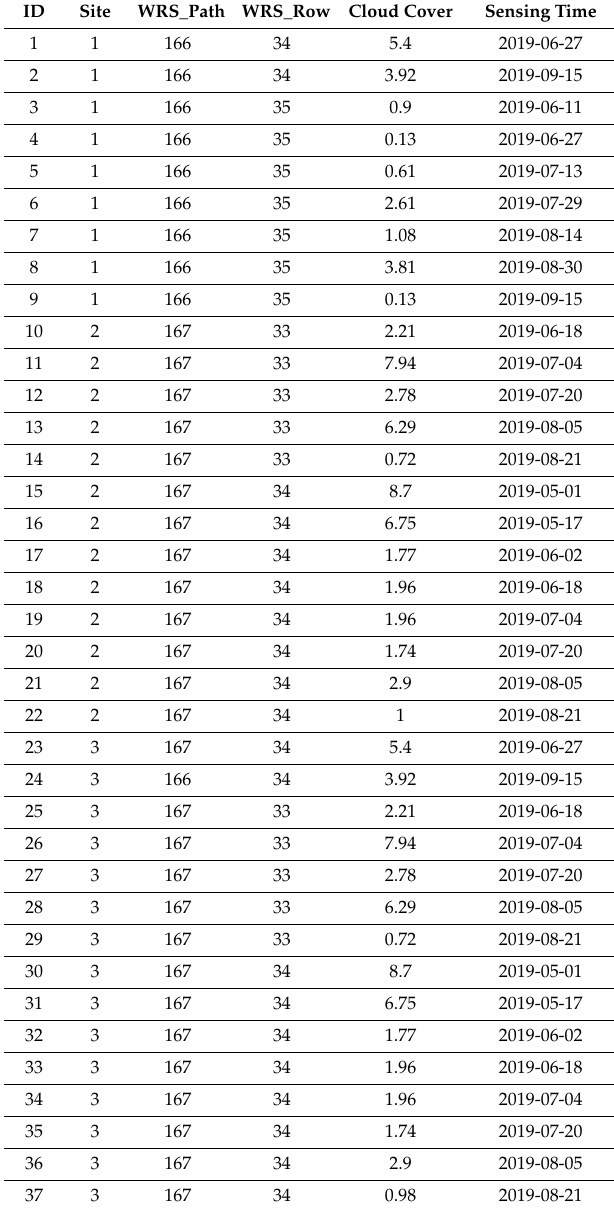
Table A1. Detailed information of the selected Landsat images (Title of all images: USGS Landsat 8 Surface Reflectance Tier